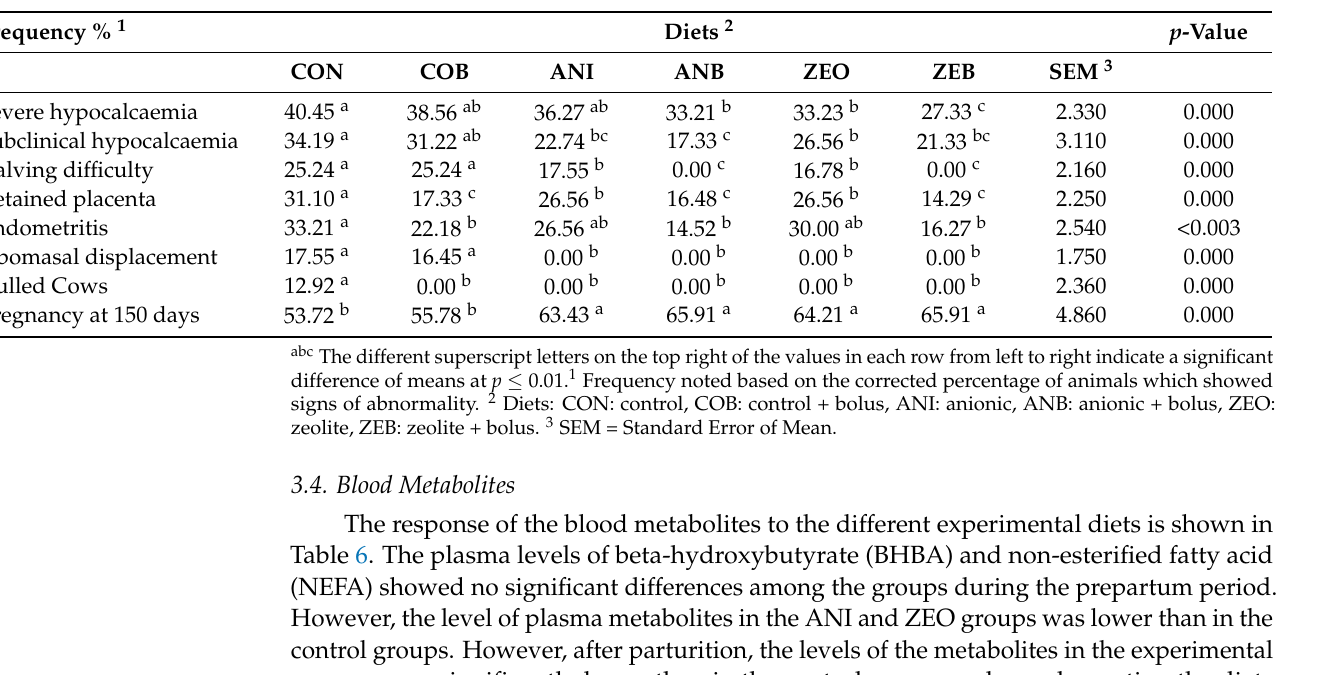
Table 5. Effect of experimental diets on prevalence of hypocalcaemia and reproduction disorders after parturition.